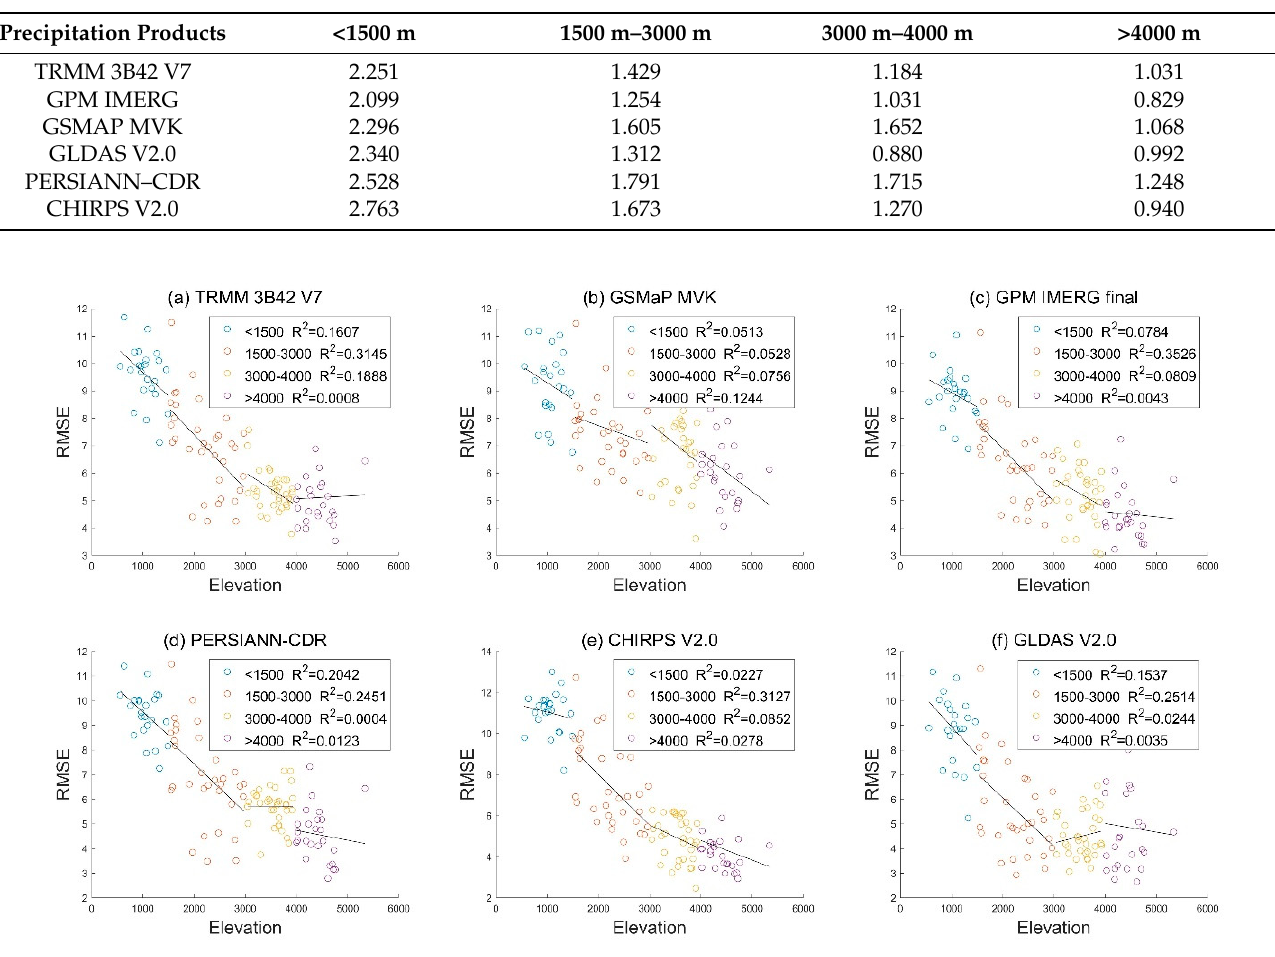
Table 9. MAE between different elevation intervals.